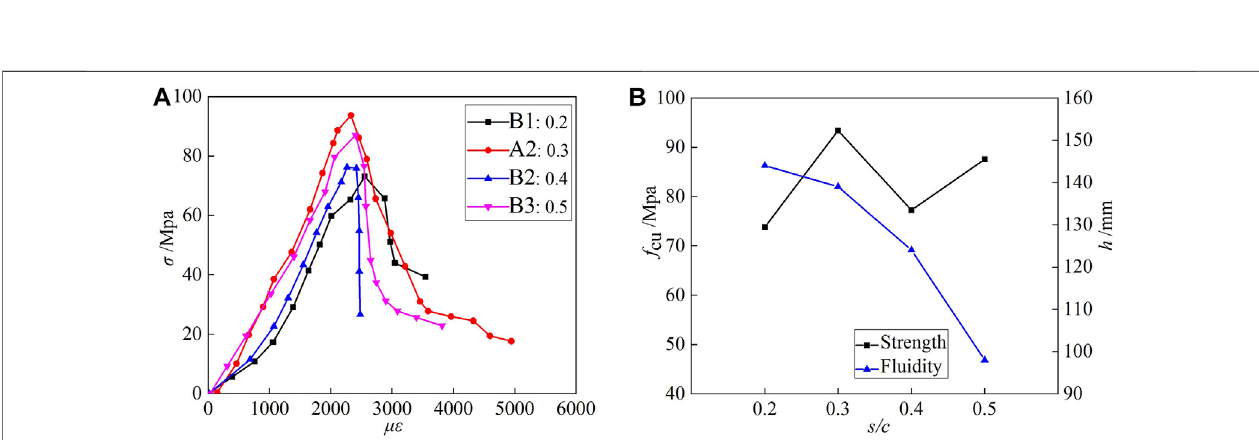
FIGURE6 | The in fl uence ofdifferent ratios of silicafume tocementon RPC mechanical properties. (A) Stress-strain curves ofRPC specimens with different ratios of silica fume to cement; (B) ultimate compressive strength and mixture fl uidity of RPC with different ratios of silica fume to cement.